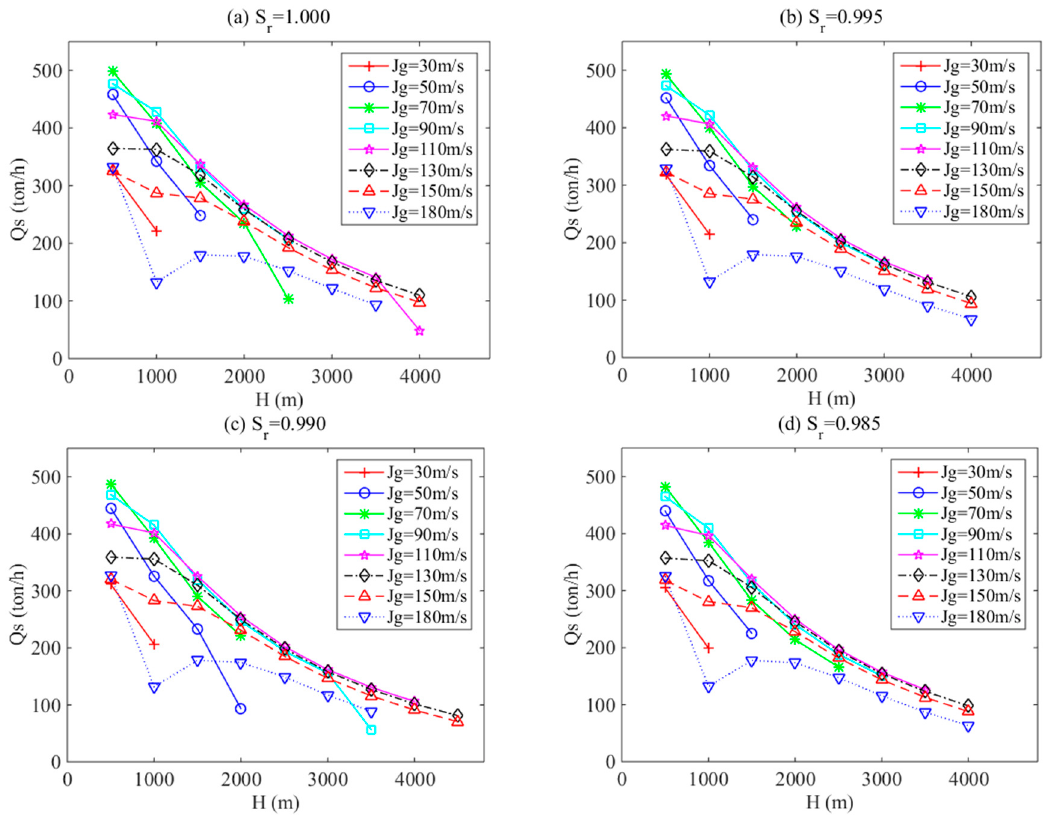
Figure 5. Figure of solid production rate Qs influenced by submergence ratio S r at different mining depth H and gas flux rate Jg . The submergence ratio of ( a – d ) are 1.000, 0.995, 0.990, 0.985, respectively.